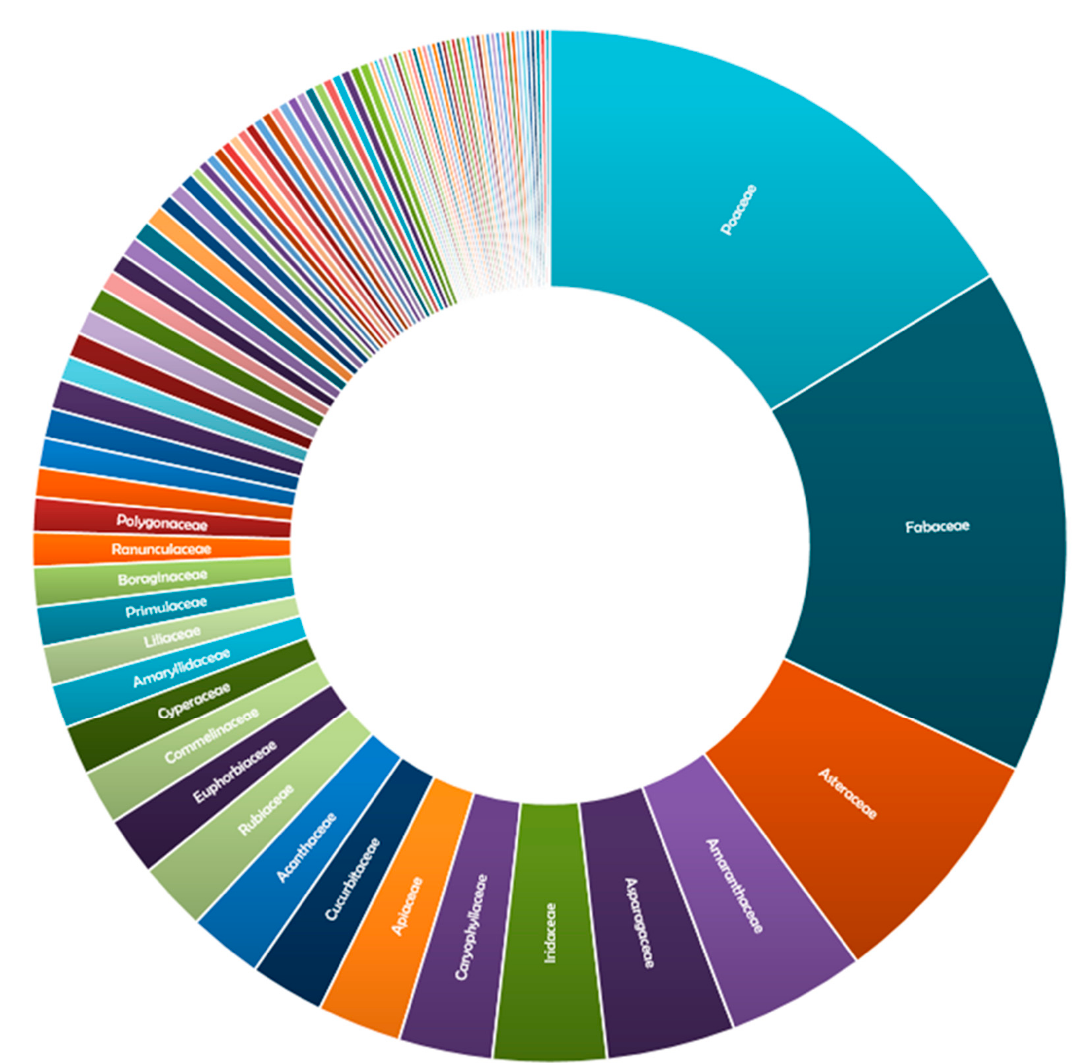
Figure 7. Family-wise comparison of genera of infected host plants.